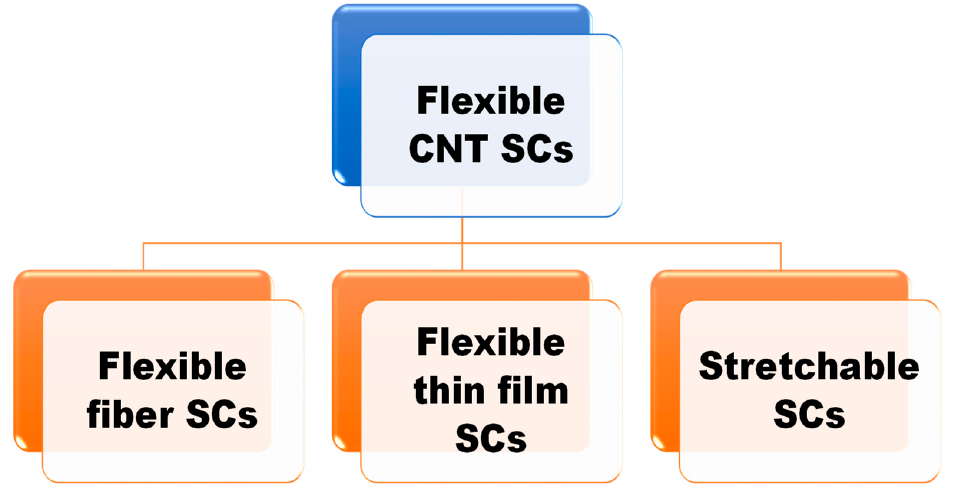
Figure 1. Hierarchical representation of various flexible carbon nanotube (CNT)-based supercapacitor models.